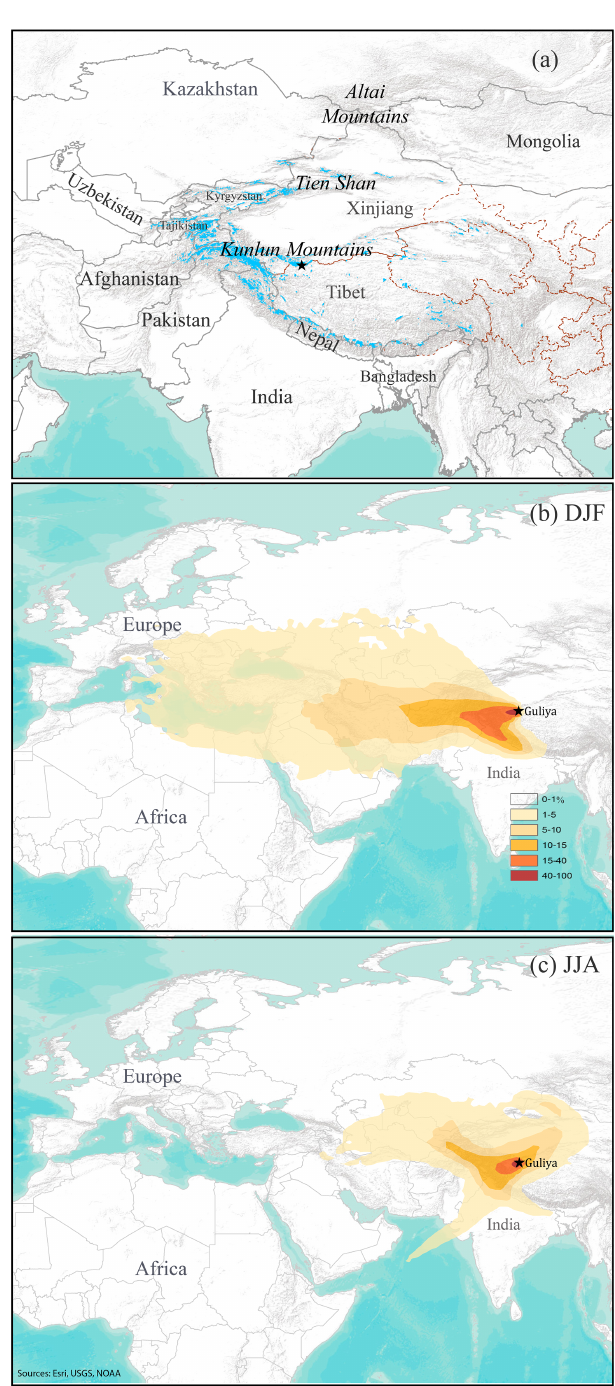
Figure 1. Maps showing the location of the Guliya ice cap (star) and the three mountain ranges of the province of Xinjiang (a) , and seasonal NOAA HYSPLIT 7d back-trajectory frequency plots for December, January, and February (b) and June, July, and August (c) for the 1992–2015 period (Rolph et al., 2017; Stein et al.,